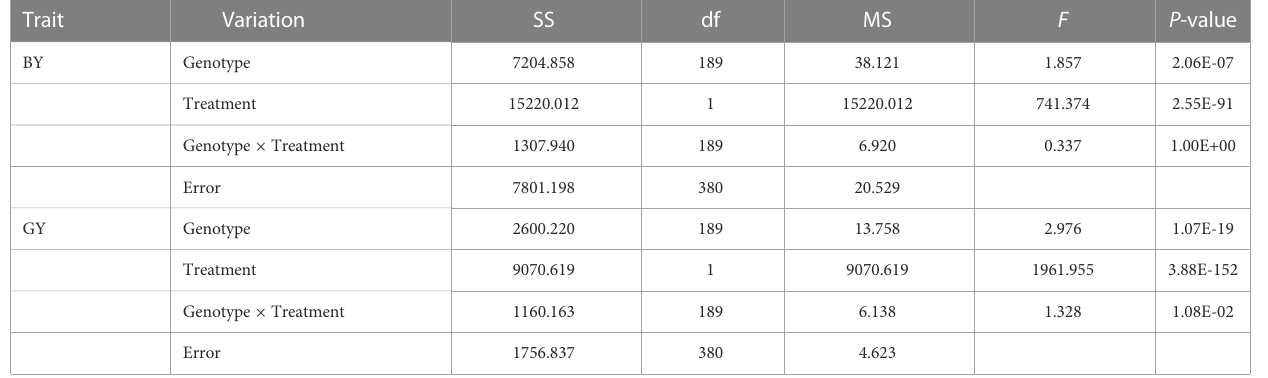
TABLE 2 ANOVA of traits based on data from experiments in two years. Trait Variation SS df MS BY